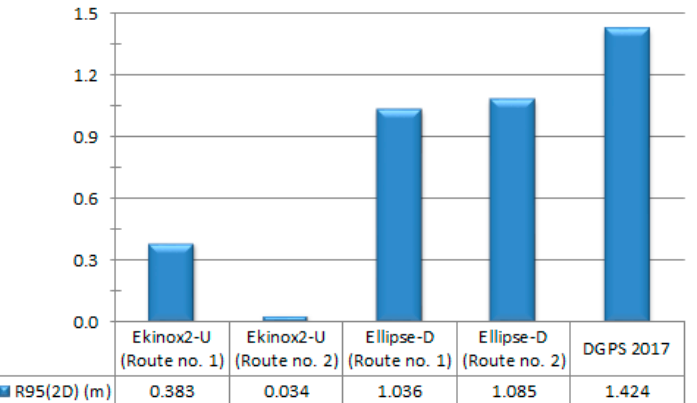
Figure 13. The R95(2D) measure values for the GNSS/INS systems on individual routes, and for the DGPS system from 2017.